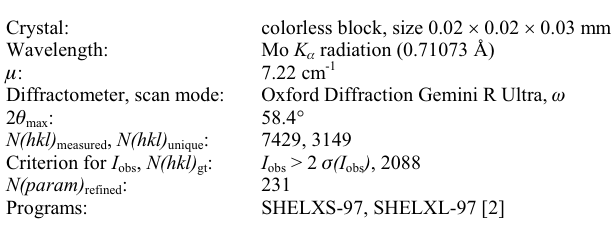
Table 1. Data collection and handling.